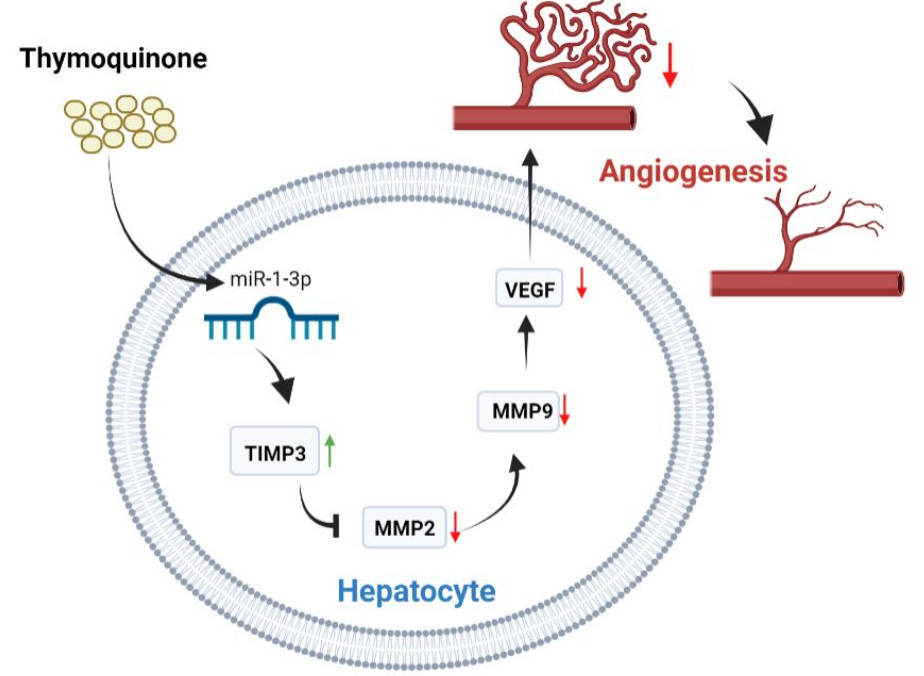
Figure 5. The role of thymoquinone in inhibiting angiogenesis through TIMP3/MMP2/MMP9/VEGF pathway.